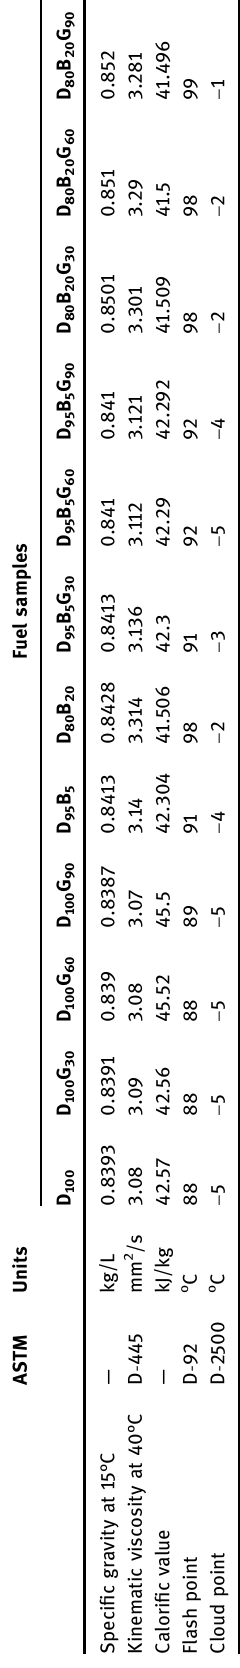
Table 4: Speci fi cations of the employed diesel engine, dynam - ometer, and the measuring instrument for engine parameters